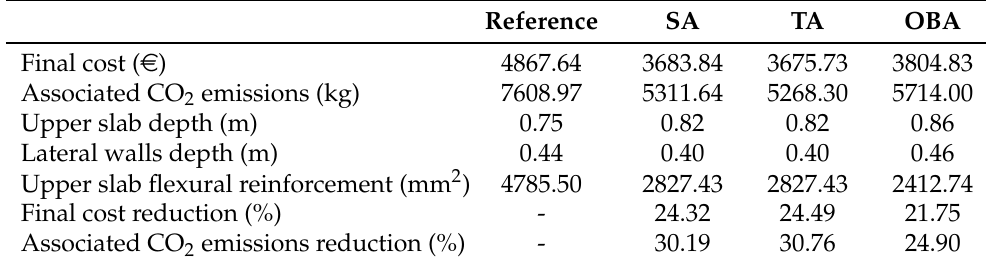
Table 5. Summary of the reference and the SA, TA and OBA algorithms